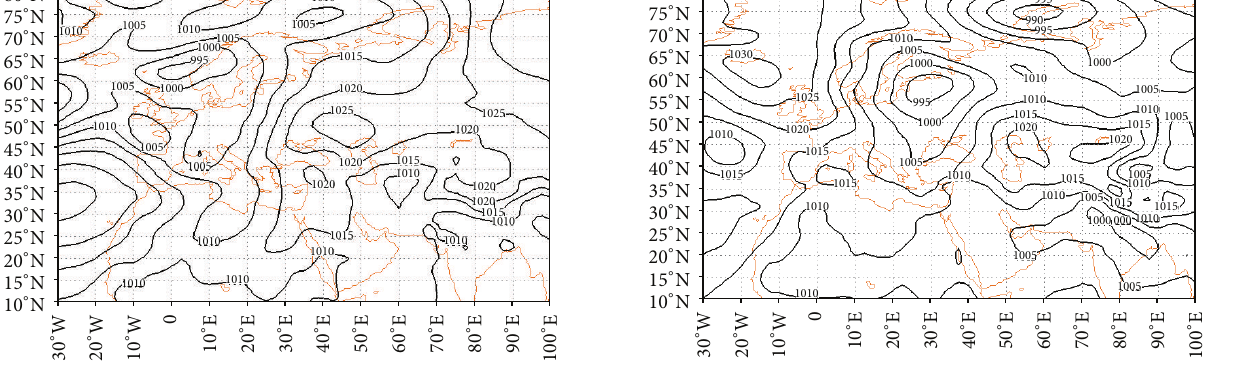
Figure 27: Sea level pressure map in representative day of pattern A.